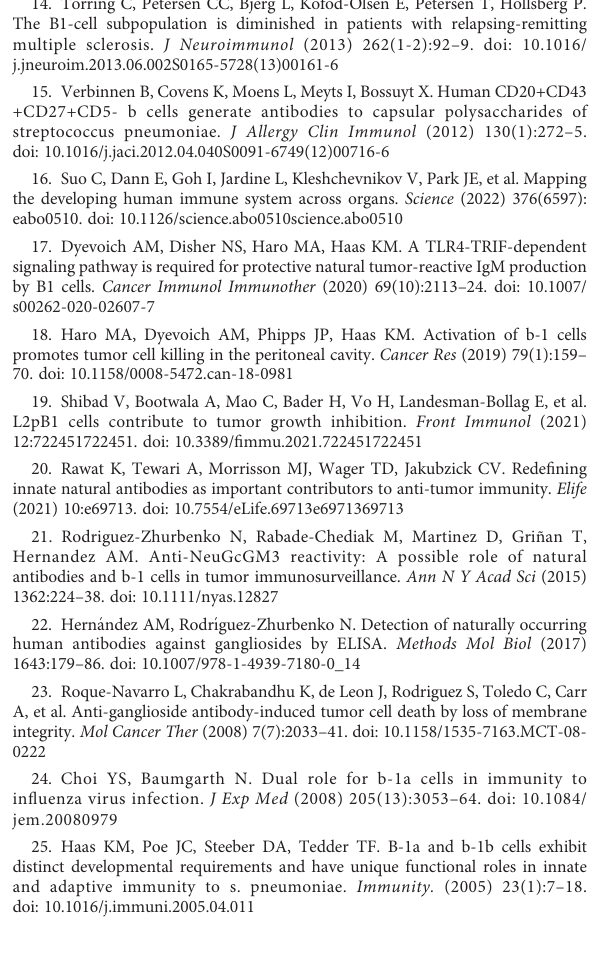
SUPPLEMENTARY FIGURE 1 Phenotypic analysis of human peripheral blood B-cell subsets by fl ow cytometry. Representative gating strategy to analyze and purify different human B-cell subsets. PBMCs were stained with Live/Dead Fixable Aqua Dead Cell Stain Kit and antibodies speci fi c for human CD3, CD4, CD7, CD19, CD20, CD27, CD38, and CD43. After doublet and death cell discrimination, CD19+ cells were separated from CD3, CD4, CD7 positive cells. CD20+ cells were separate from CD20- plasma cells and plotted using CD27 and CD38 to exclude CD38 high pre-plasmablast. CD38 low/int were resolved according to CD27 and CD43 expression with mature/naive being CD27-CD43-, memory B cells CD27+CD43- and B-1 cellbeingCD27+CD43+.FluorescenceMinusOnecontrolswereusedfor CD27+ and CD43+ cells